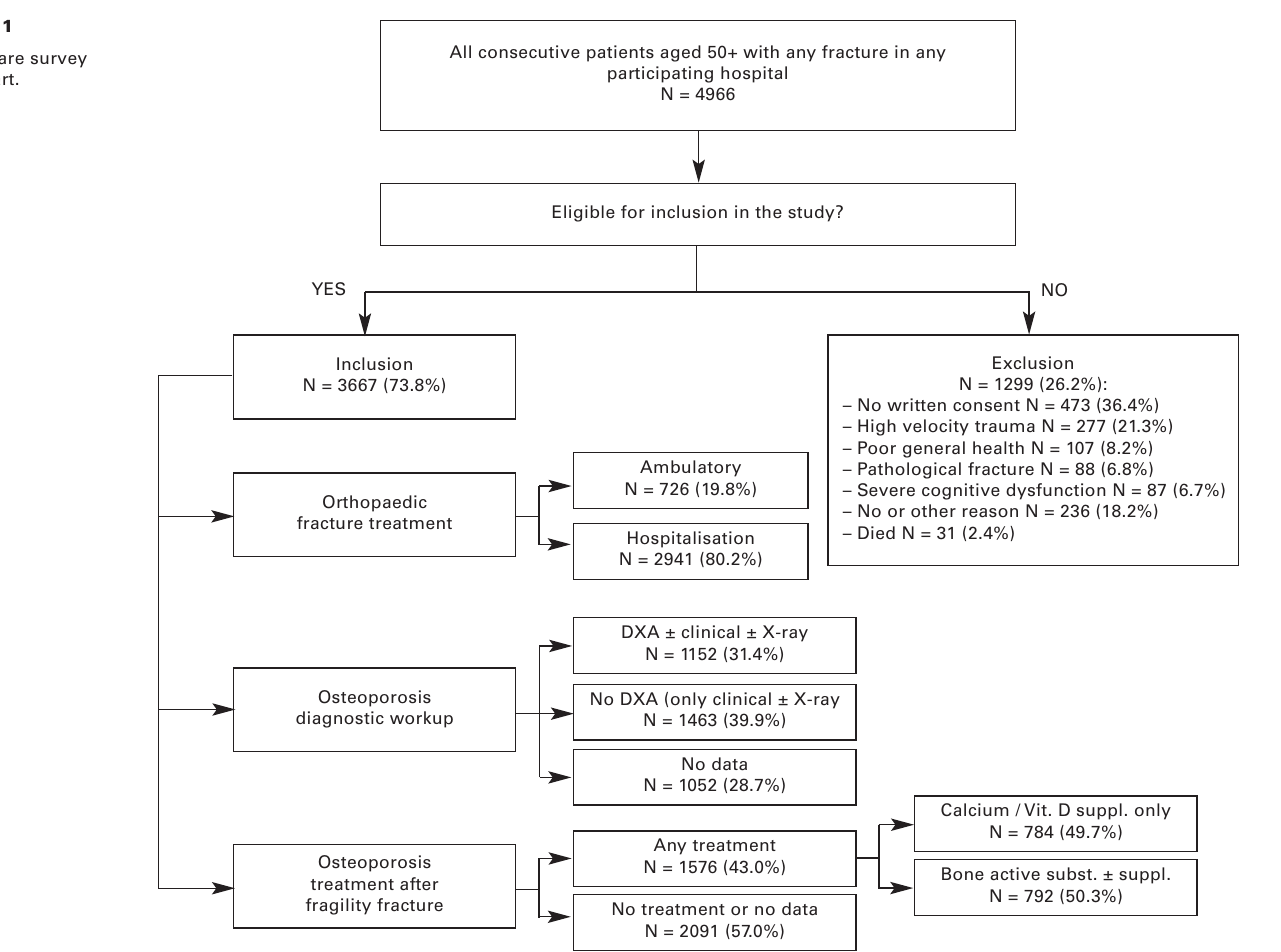
All consecutive patients aged 50+ with any fracture in any participating